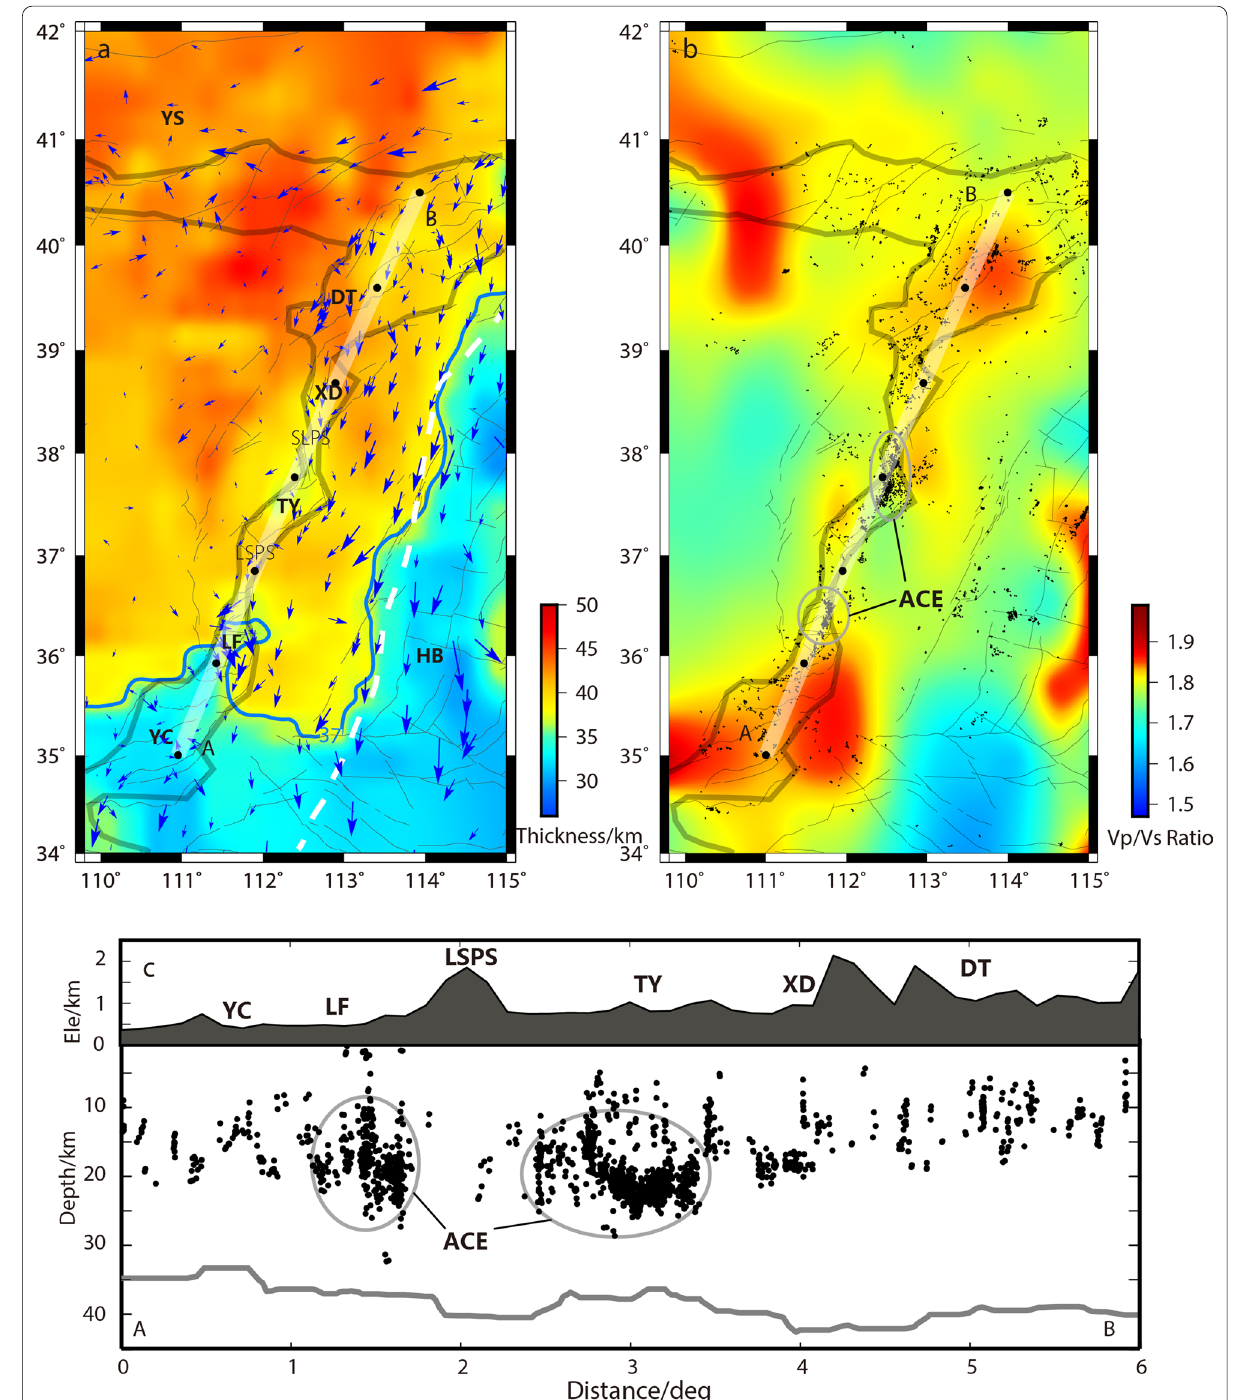
Fig. 6 Crustal thickness, Vp/Vs ratio and earthquakes distribution in the research area. a Crustal thickness. b Vp/Vs ratio. c Seismicity pattern along the Shanxi Rift shown in b . The blue arrows display GPS velocity vectors; the black dots represent the locations of earthquakes, the white dashed line indicates the north–south gravity lineament, and the gray line stands for the crustal thickness along the profile AB. YC Yuncheng graben, LF Linfen graben, TY Taiyuan graben, XD Xinding graben, DT Datong graben, YS Yinshan Mountains, HB Huabei basin, LSPS Lingshi Push-up Swell, SLPS Shilingguan Push-up Swell, ACE area with concentrated distributions of